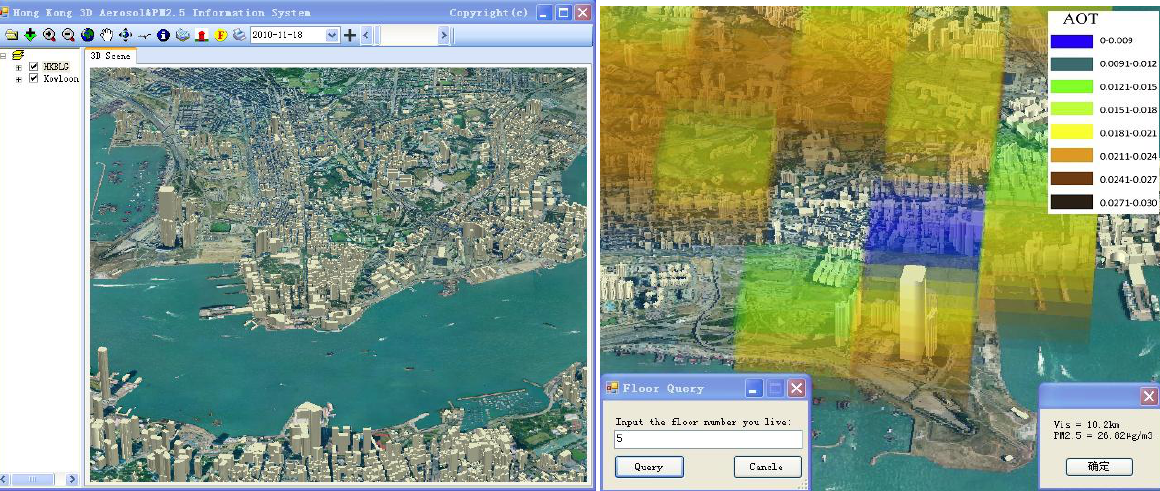
query (adopted from 2.5